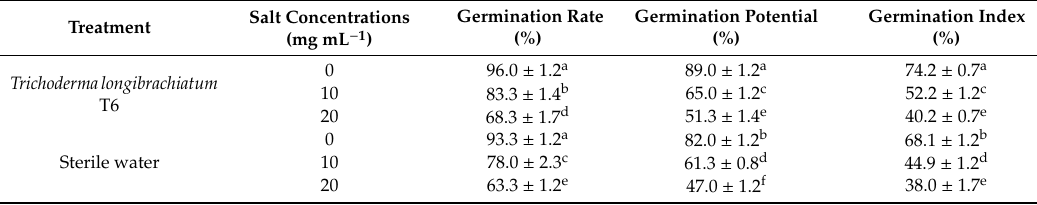
Table 1. E ff ect of the strain Trichoderma longibrachiatum T6 on wheat seed germination at the di ff erent NaCl solutions.